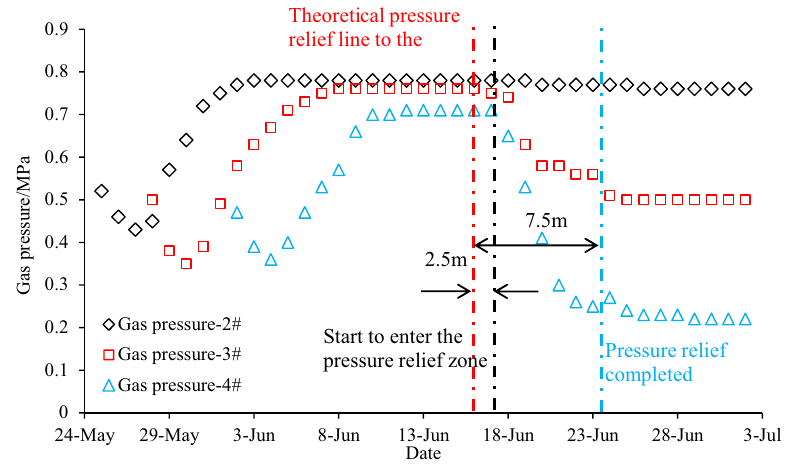
Figure 8. Gas pressure during protective coal seam